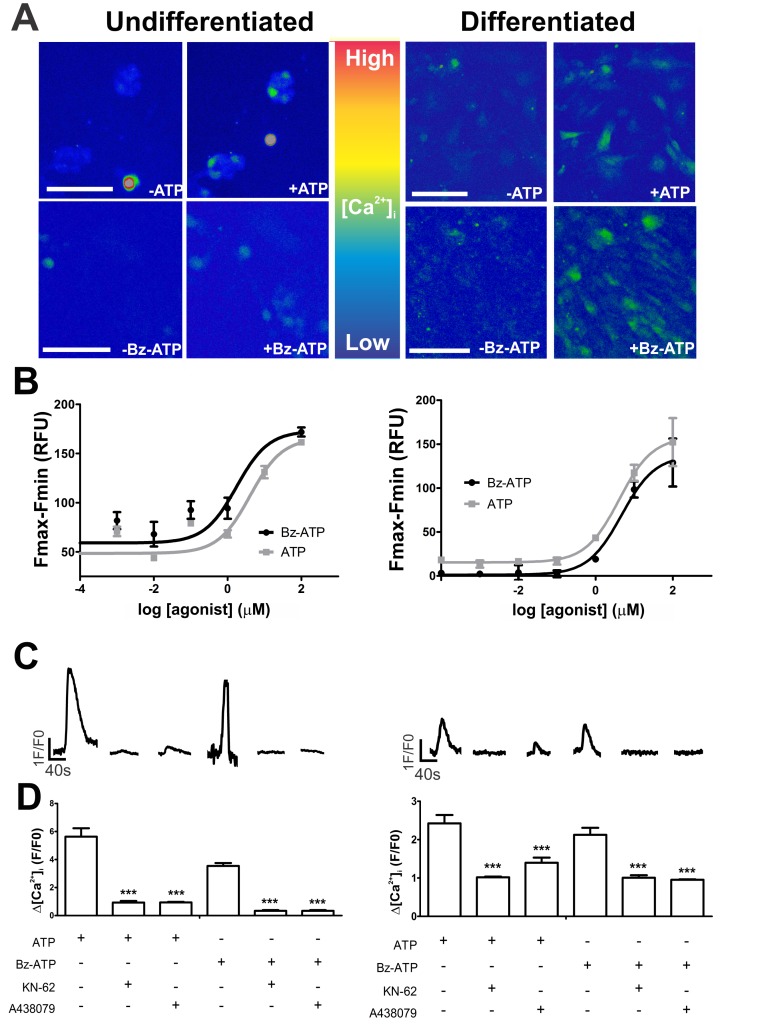
ATP- and Bz-ATP-induced intracellular calcium fluxes in undifferentiated and neural-differentiated ESC.ATP- and Bz-ATP-evoked P2X7R responses were determined by single-cell calcium imaging and microfluorimetry assays as described in Materials and Methods. (A) For calcium imaging, 10 µM of purinergic receptor agonists, ATP or Bz-ATP, were used to stimulate receptor-mediated intracellular calcium fluxes in undifferentiated and neural-differentiated cells (day 8). (B) For microfluorimetry-based calcium measurements, increasing concentrations of ATP or Bz-ATP were added and time kinetics of changes in fluorescence emission was recorded. Peak values of measured [Ca2+]i transients are reported. Nonlinear Regression was used for curve-fitting and calculating the EC50 values. (C and D) P2X7R inhibitors were studied regarding their effects in blocking ATP- and Bz-ATP-induced [Ca2+]i transients, as studied by calcium imaging. For these experiments, cells were pre-treated for 2 min with 10 µM KN-62 or 1 µM A438079 and then stimulated with 10 µM ATP or Bz-ATP. Data represent mean values ±S.E. of three independent experiments performed in triplicate.